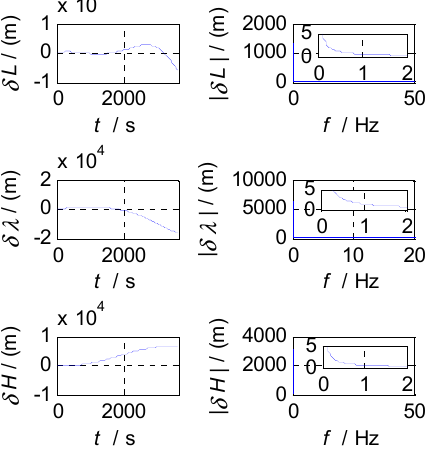
Figure 10. Position errors and frequency characteristics of SINS.